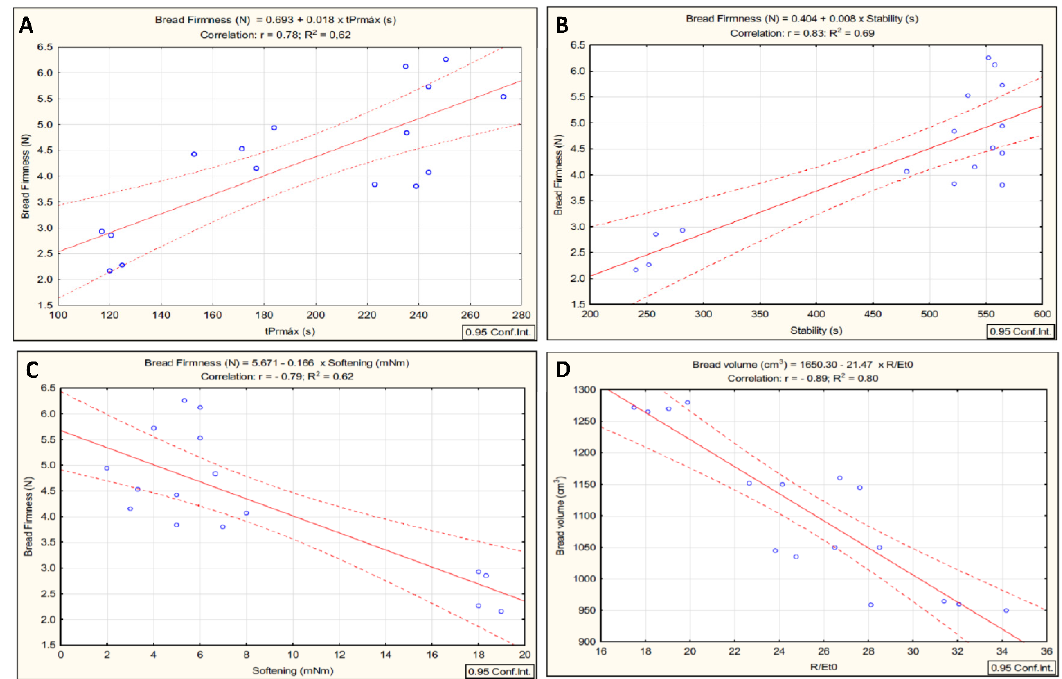
Figure 3. Correlations between breadmaking properties and dough rheology parameters ( p < 0.05).